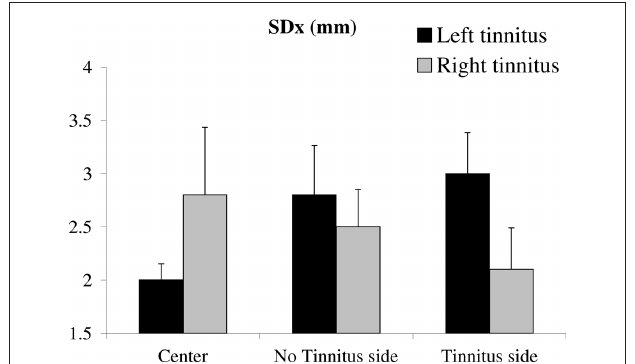
FiGuRE 2 | Significant interaction between gaze position and subgroup of tinnitus subjects: for subjects with left tinnitus only (as determined in text) medio-lateral body sway is optimal for the straight ahead gaze position but deteriorated significantly when looking away, on either side. For right tinnitus gaze position modulation is not significant.